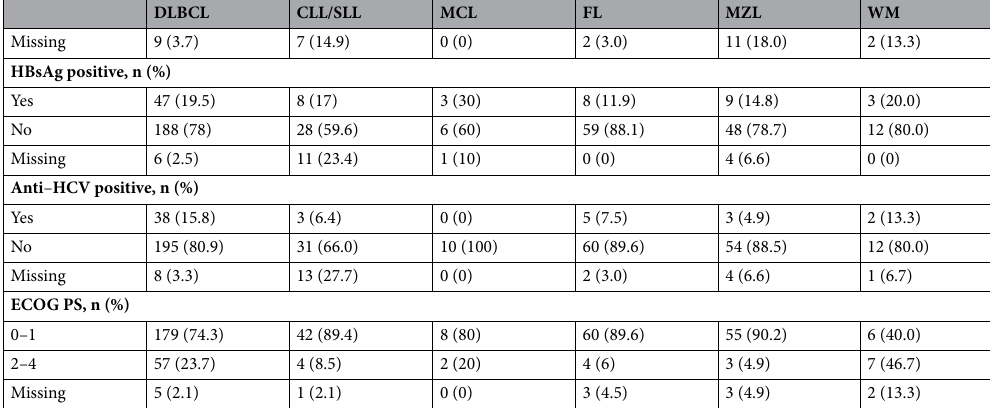
Table 1. Baseline demographic characteristics of patients with B-NHL in Kaohsiung Chang Gung Memorial Hospital (2008–2013). ALC absolute lymphocyte count, ALT alanine transferase, ANC absolute neutrophil count, CLL/SLL small lymphocytic lymphoma and chronic lymphocytic, DLBCL diffuse large B-cell lymphoma, ECOG PS Eastern Cooperative Group performance score, FL follicular lymphoma, HBsAg hepatitis B surface antigen, HCV hepatitis C virus, LDH lactate dehydrogenase, SD standard deviation, MCL mantle cell lymphoma, MZL marginal zone lymphoma, WM Waldenström’s macroglobulinemia or lymphoplasmacytic lymphoma.